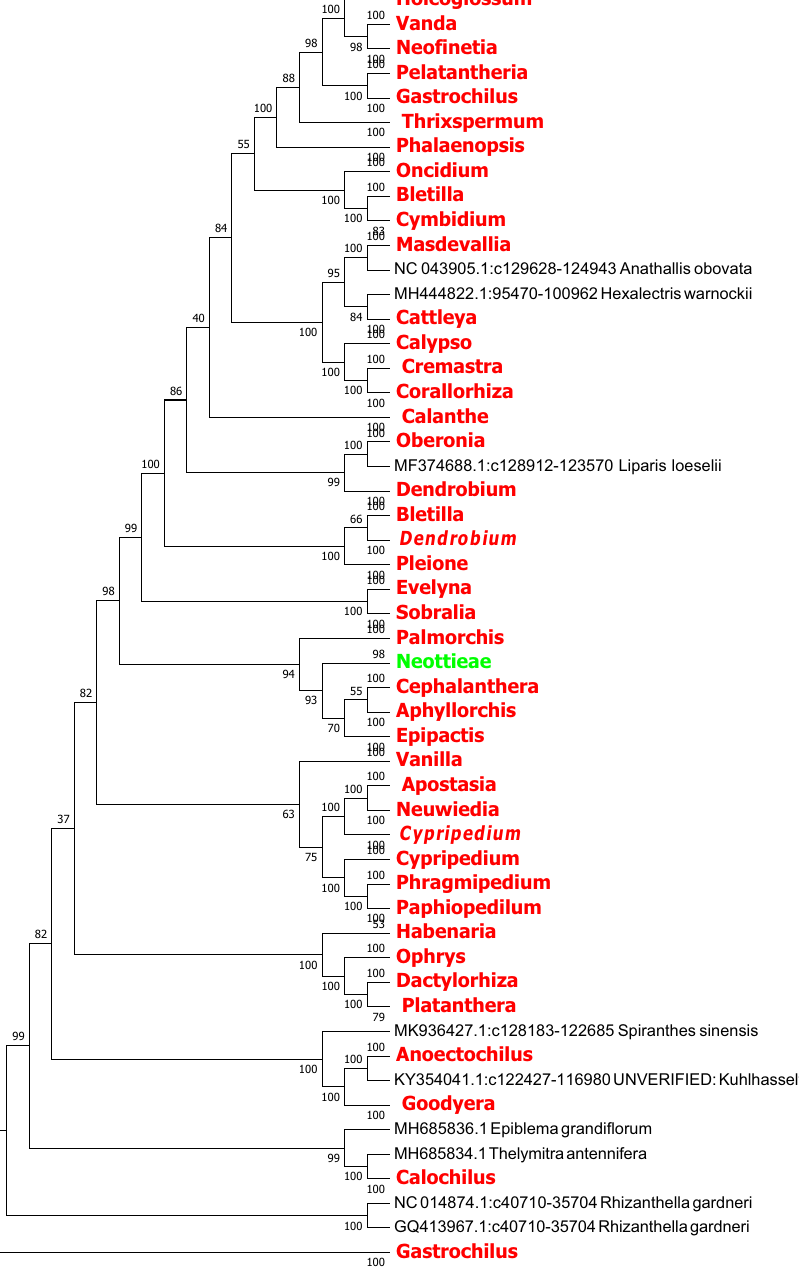
Figure 5. The NJ tree of Orchidaceae coming from analysis of the cp DNA ycf1 sequence based on the K2P model. Names tagged in red indicates the genus and tagged in green showed the subtribe; The Numbers on the branches represent more than or equal to 50 percent support after the 1000 bootstrap replications test; Numbers following taxon names showed the number of